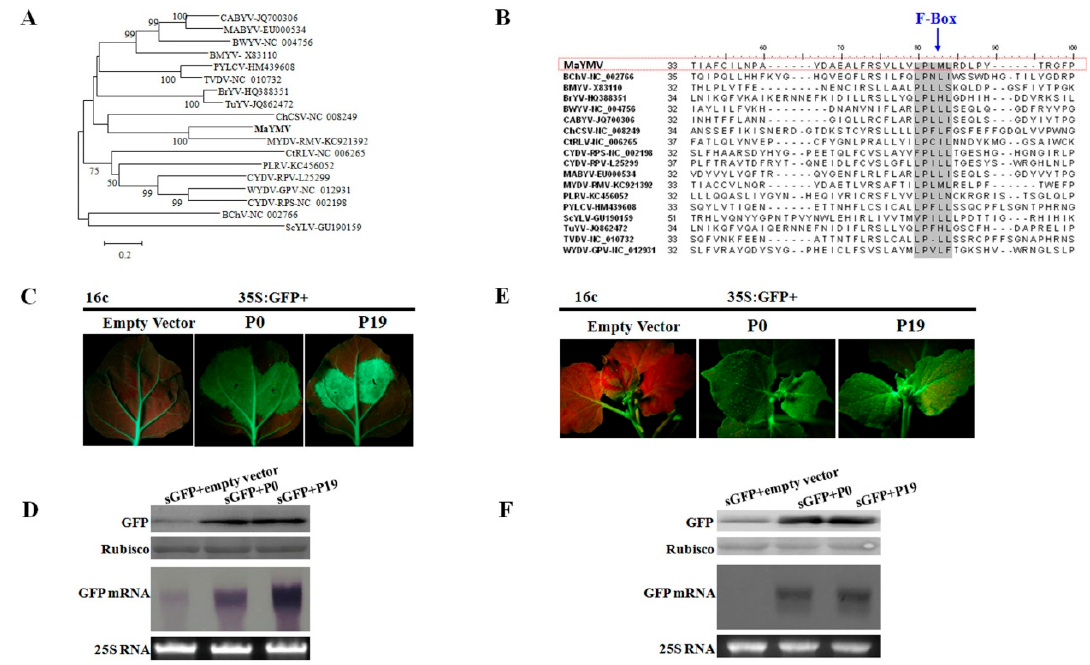
Figure 5. Analysis of the local and systemic silencing of GFP mRNA in transgenic N. benthamiana line 16c using ectopic expression of the MaYMV P0 in an agro-coinfiltration assay. ( A ) amino acid sequences of the P0s encoded by polereoviruses were aligned using the MUSCLE algorithm. The aligned sequences were used for inferring evolutionary relationships using the neighbor-joining method. The resulting tree, drawn to scale, is shown with the bootstrap of 1000 replicates; ( B ) multiple alignment of the polerovirus P0 amino acid sequences encompassing a conserved F-box motif LPxxL/I; ( C ) suppression of local silencing by MaYMV P0 protein. Images of infiltrated leaves were taken under long wave length UV light at 5 dpi; ( D ) Western blot analyses of GFP accumulation (in top panels) or Northern blot analyses of GFP mRNA levels (in bottom panels) in the extracts from the agro-infiltrated leaves are shown in ( C ); ( E ) suppression of systemic silencing by MaYMV P0 protein. The agro-infiltrated plants were imaged at 20 dpi. The infiltration combinations of sGFP with either empty vector or P19 were used as negative and positive controls, respectively; and ( F ) immunoblot analyses of GFP accumulation (in top panels) or Northern blot analyses of GFP mRNA levels (in bottom panels) in the extracts from the systemic leaves are shown in ( E ).